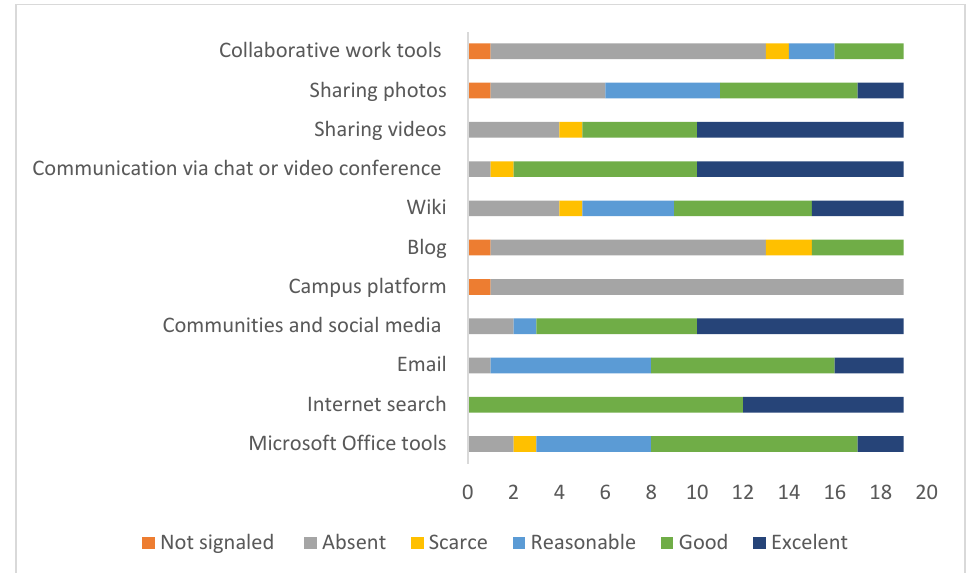
Figure 3. 7th grade s tudent’s level of knowledge about web applications or services . 5th grade students (Figure 4) reported excellent or good knowledge of video sharing tools (56 students), Internet search (58), chat or videoconferencing tools (57) and partici- pation in communities or social networks (48). However, many students reported not knowing collaborative work tools (46 students), photo sharing (42), blogs (37) and Campus platform (59). The majority of these students do not have an account on social media. For instance, only 20 of them have an Instagram account.